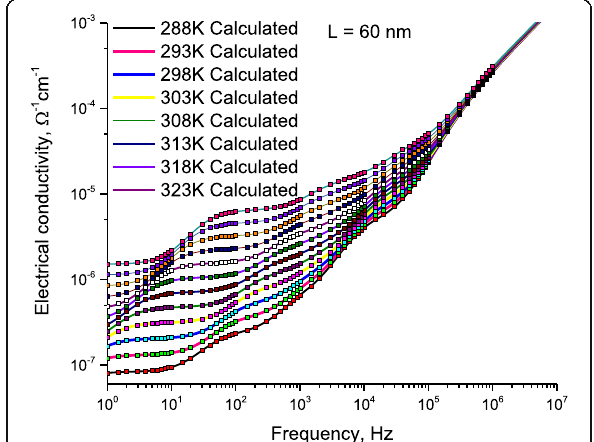
Fig. 14 AC-conductivity as a function of frequency for DNA molecule as a function of frequency, for different temperatures. Lines represent calculated values after Eq. (12) with the data in Figs. 8 and 9. Symbols represent experimental values. Lines on figure illustrate the effect of temperature on four humps (H2, H3, H4, and H5). Hump H1 is independently represented in Fig. 15 because the scale, here, is not suitable to represent all H1